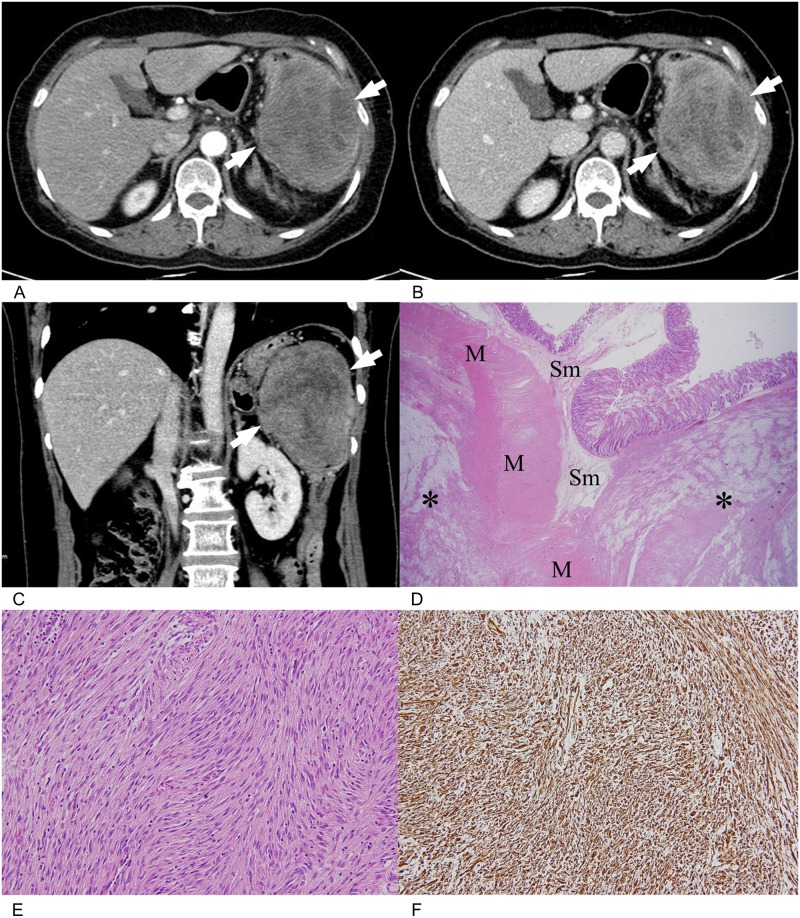
A 57-year-old woman with colonic gastrointestinal stromal tumor (GIST).(A), (B). On arterial (A) and portal (B) axial CT images show a 10 cm large heterogeneous ovoid mass (arrows) in the descending colon. The mass shows high attenuation than back muscle on both phases. (C). Coronal CT image also demonstrates a large heterogenous mass (arrows) in the descending colon. (D). Left hemicolectomy was performed and histopathology (H&E, x10) revealed spindle cell type tumor (*) invading submucosa (Sm) and proper muscle (M). (E). High-power field microscopic photograph (H&E, x100) shows a highly cellular tumor composed of broad bundles of elongated cells. Mitotic count of this tumor was 15/50 HPFs. (F). Tumor cells are diffusely c-kit positive on immunohistochemistry. Therefore, GIST with high risk of malignancy was finally diagnosed. H&E = hematoxylin and eosin. HPF = high-power field.